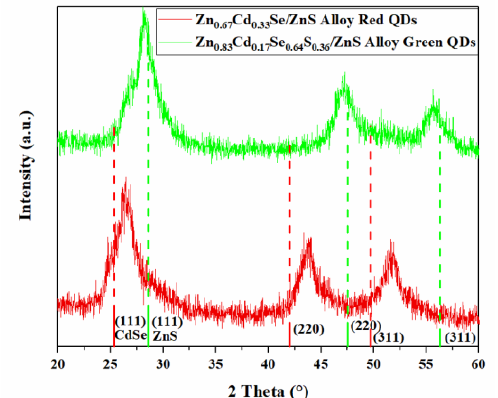
Figure 3. XRD results of powdered samples of red and green QDs. The XRD PDF standard card of CdSe (red bars, JCPDF of No. 19-0191) and ZnS (green bars, JCPDF of No. 05-0566) are also exhibited under XRD results, respectively, as the